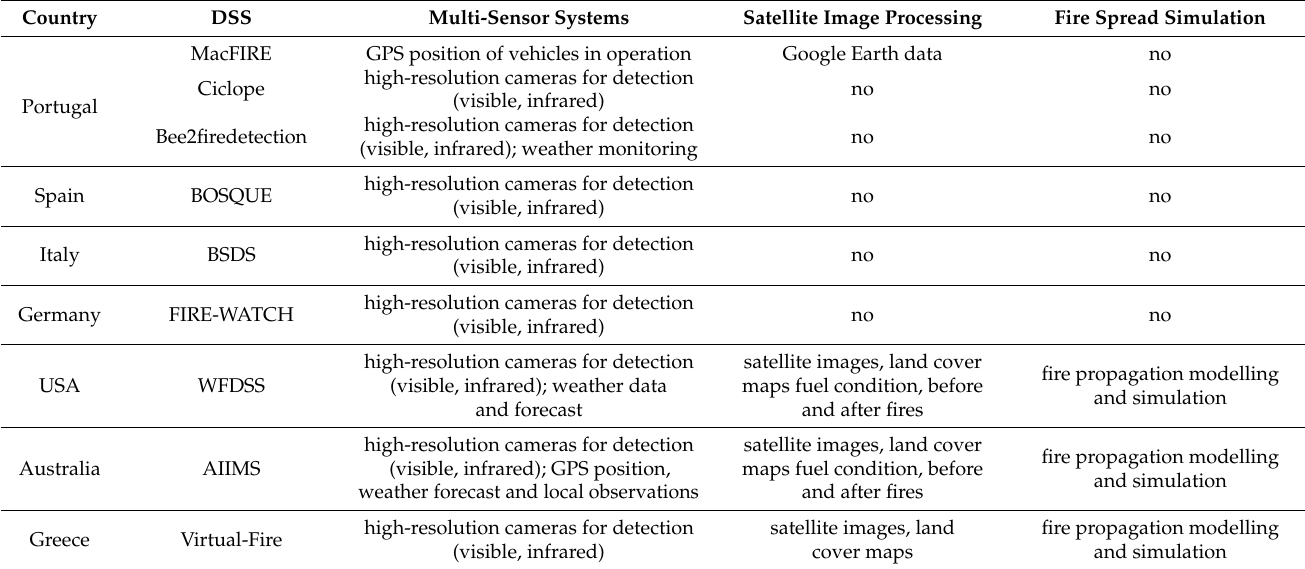
Table 1. A comparative table of existing